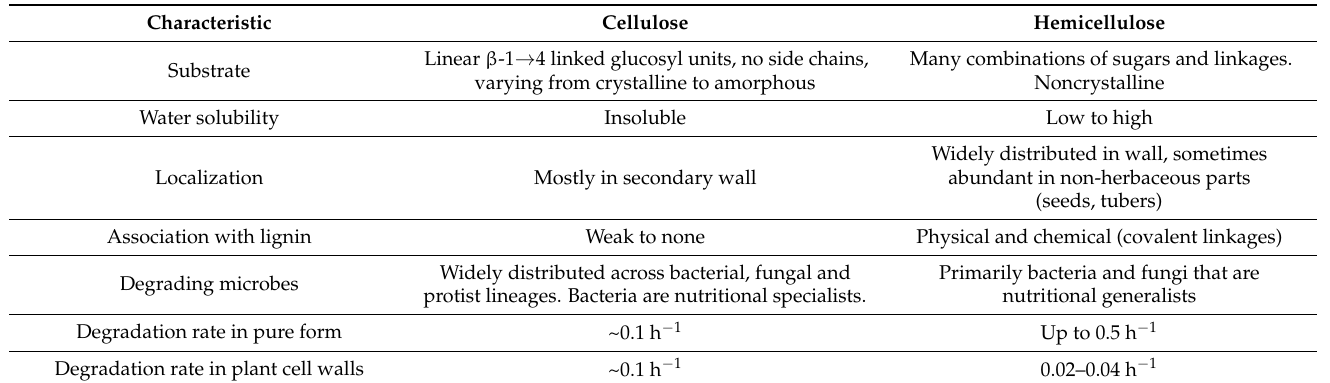
Table 4. Differences in cellulose and hemicellulose degradation by ruminal